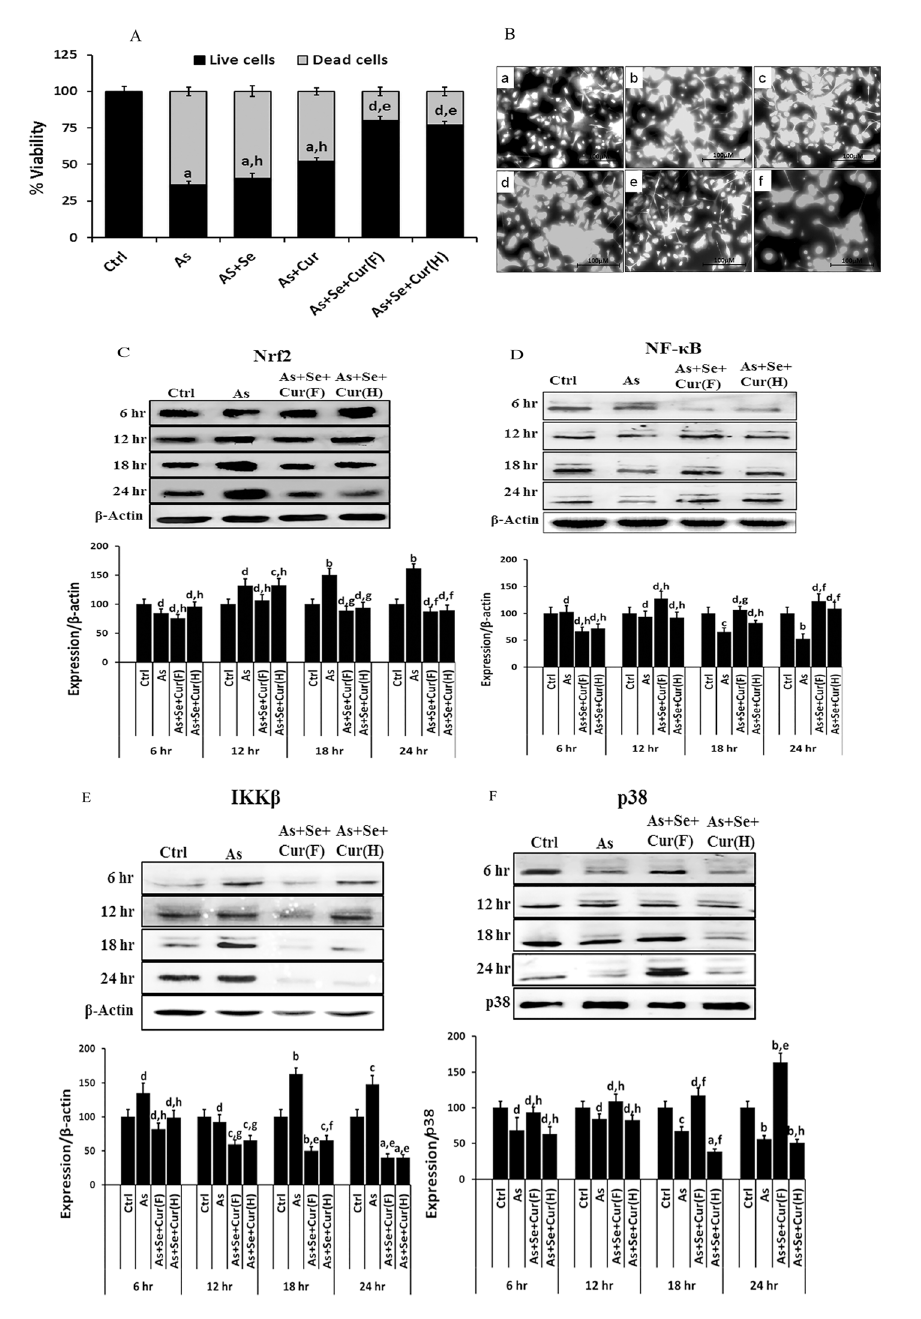
Fig 5. In vitro acute exposure to iAs and/or additives induced (A) cytotoxicity and viability, (B) levels of GSH, (C) time course of Nrf2 expression, (D) time course of NFkB expression, (E) time course of IkB expression, (F) time course of phosphorylated-P38 expression in neonate EpASCs. Data are expressed as mean of three different experiments; ± SEM, ‘ p ’ values are a < 0.001, b < 0.01, c < 0.05, d > 0.05 vs. control and e < 0.001, f < 0.01, g < 0.05, h > 0.05 vs.